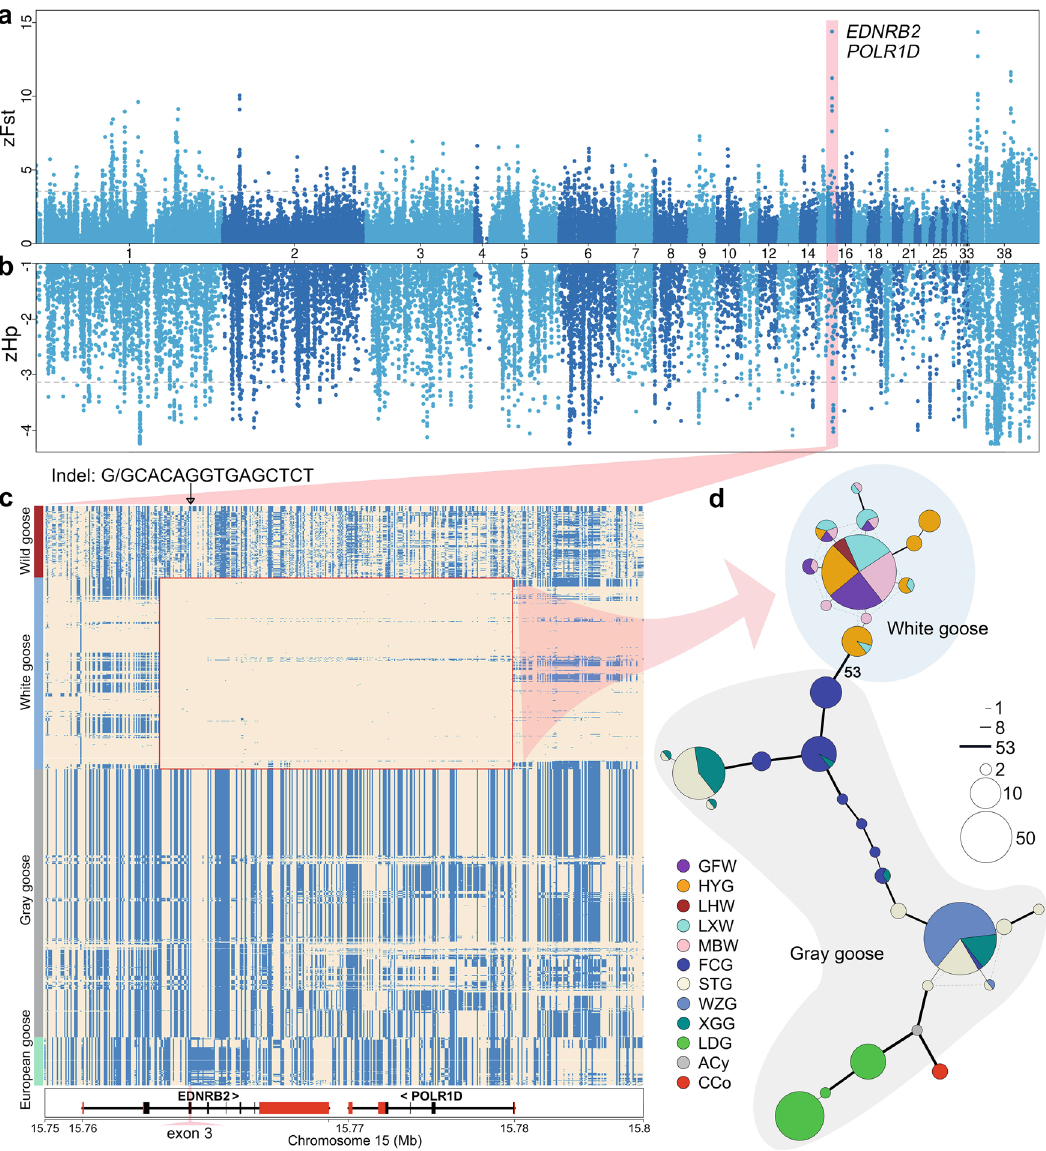
Fig. 4 Selective signals for the white plumage phenotype of geese. a Manhattan plot of zFst between white and gray geese. The x -axis of the Manhattan plot shows the ordered chromosome that is de fi ned in Supplementary Table 2, and 38 represents Z chromosome. b Manhattan plot of zHp in white geese, with the positions matching zFst. The gray dashed line represents the top 1% cutoff. c The plot of the haplotype structure of variants around the EDNRB2 and POLR1D genes in all domestic geese and wild populations (The genera Anser and Cygnus in the Anatidae family). Major and minor alleles in GFW are indicated by beige and light blue, respectively. The red box represents the unique haplotypes of white geese. The black arrow indicates the position (15,764,637 bp) of the candidate causal 14-bp insertion for the white geese. The red and black rectangles in the bottom box represent the UTRs and CDSs, respectively. d Haplotype network based on 285 SNPs and Indels from the EDNRB2 gene (15,763,328 bp) to POLR1D gene (15,779,122 bp) on chromosome 15. Each circle represents a haplotype, and the size of the circle is proportional to the haplotype frequency. The line width and length represent the difference between haplotypes. GFW Guangfeng white goose, HYG Huoyan goose, LHW Lianhua white goose, LXW Lingxian white goose, MBW Mingbei white goose, FCG Fengcheng gray goose, STG Shitou goose, WZG Wuzong goose, XGG Xingguo gray goose, LDG Landaise goose, ACy Anser cygnoides , CCo Cygnus columbianus